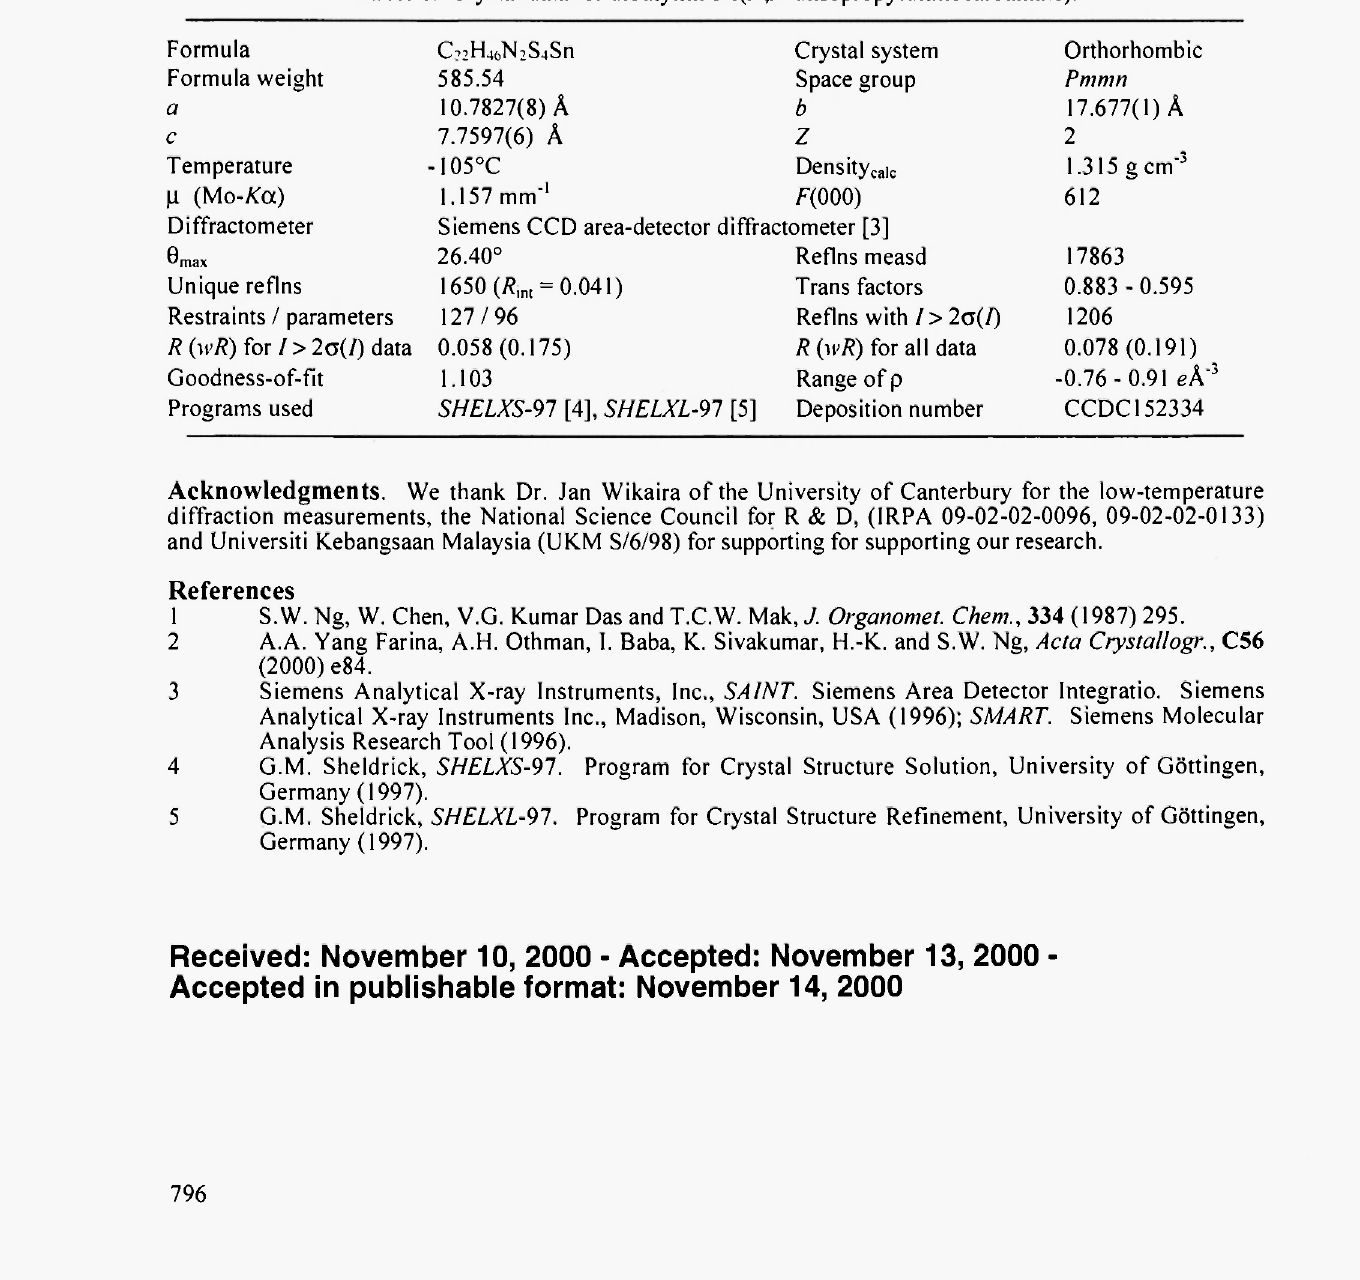
Table 1. Crystal data for dibutyltin